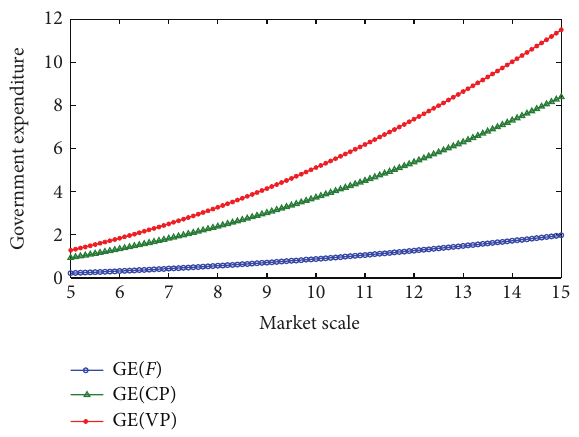
Figure 8: Three tools comparison on welfare under the change of market scale 𝛼